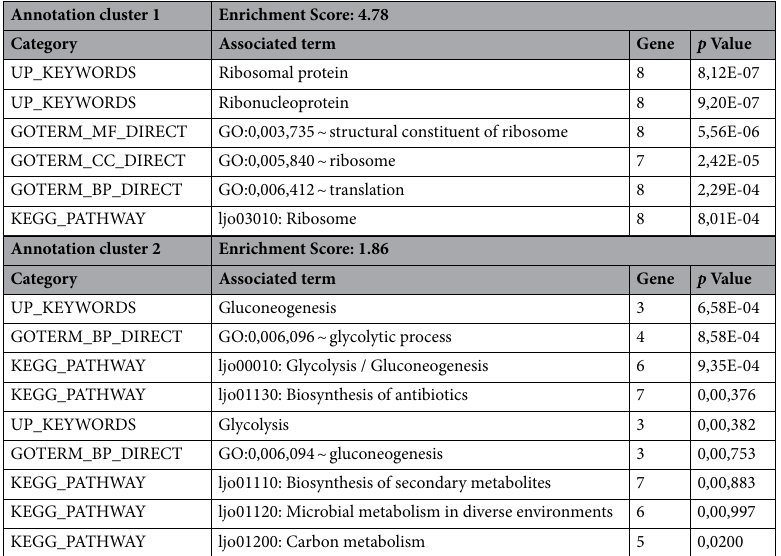
Table 3. GO-Functional Annotation Clusters for L. johnsonii proteins. The following clusters, resulting from the DAVID-GO Functional Annotation Clustering, represent the secreted proteins of LJO02 cultured in TIL.